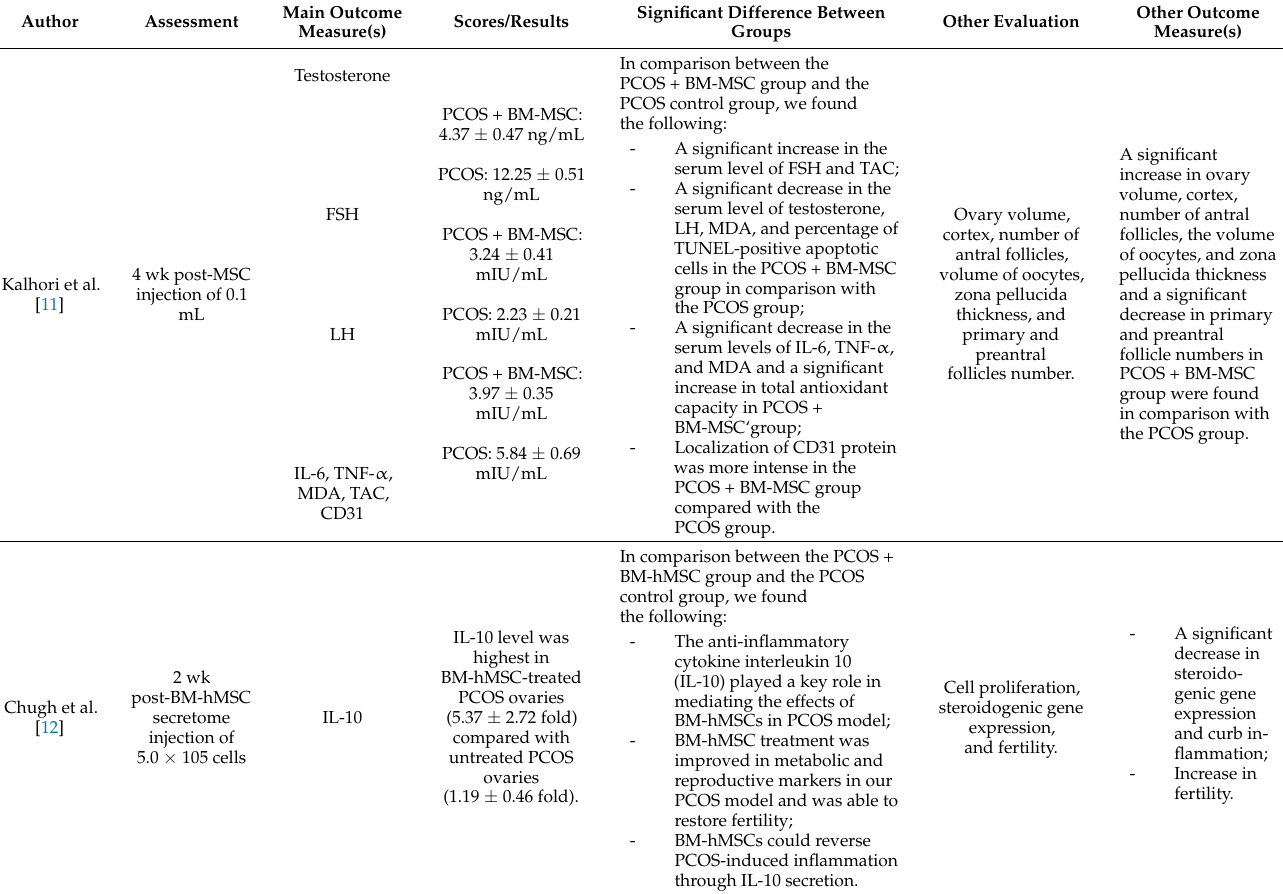
Table 2. In vivo study